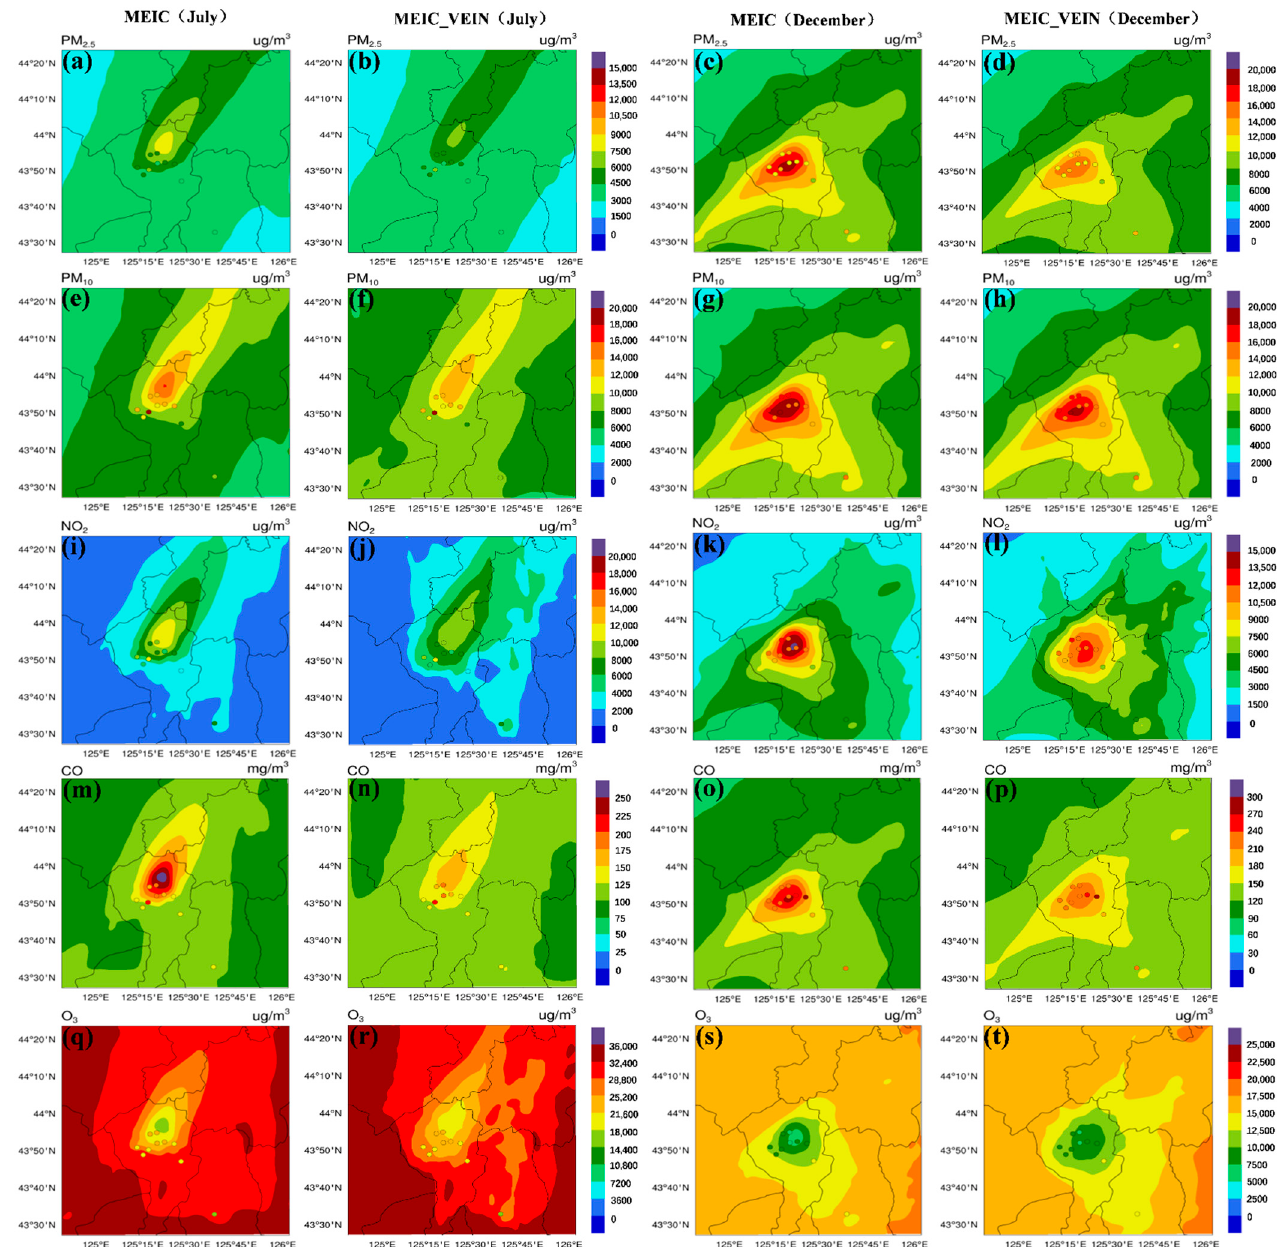
Figure 3. The accumulated pollutant concentrations of hindcast simulations with/without